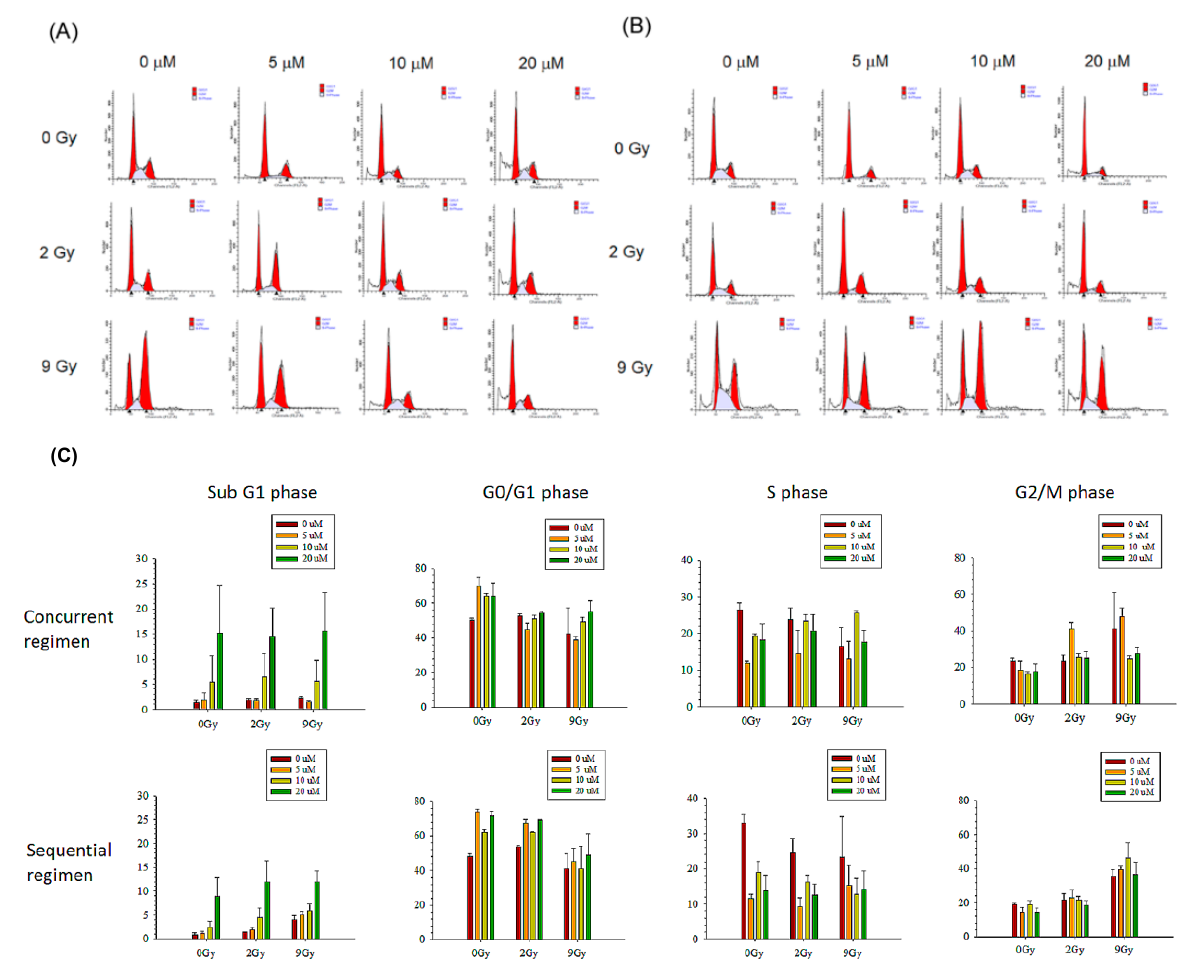
Figure 6. Huh-7 cells were treated with regorafenib at concentrations of 0, 5, 10 or 20 µmol/L (µM). ( A ) The percentage of hypodiploid cells (sub-G1) was quantified in plates 1 h after irradiation (concurrent group) with sham RT (RT 0 Gy ), 2 Gy (RT 2 Gy ) and 9 Gy (RT 9 Gy ). ( B ) The percentage of hypodiploid cells (sub-G1) was quantified in plates 24 h after irradiation (sequential group) with different RT doses. ( C ) Bar graphs showing the cell cycle distributions of the different treatment regimens. Data from three separate experiments are expressed as the mean ± standard error of the mean (SEM).